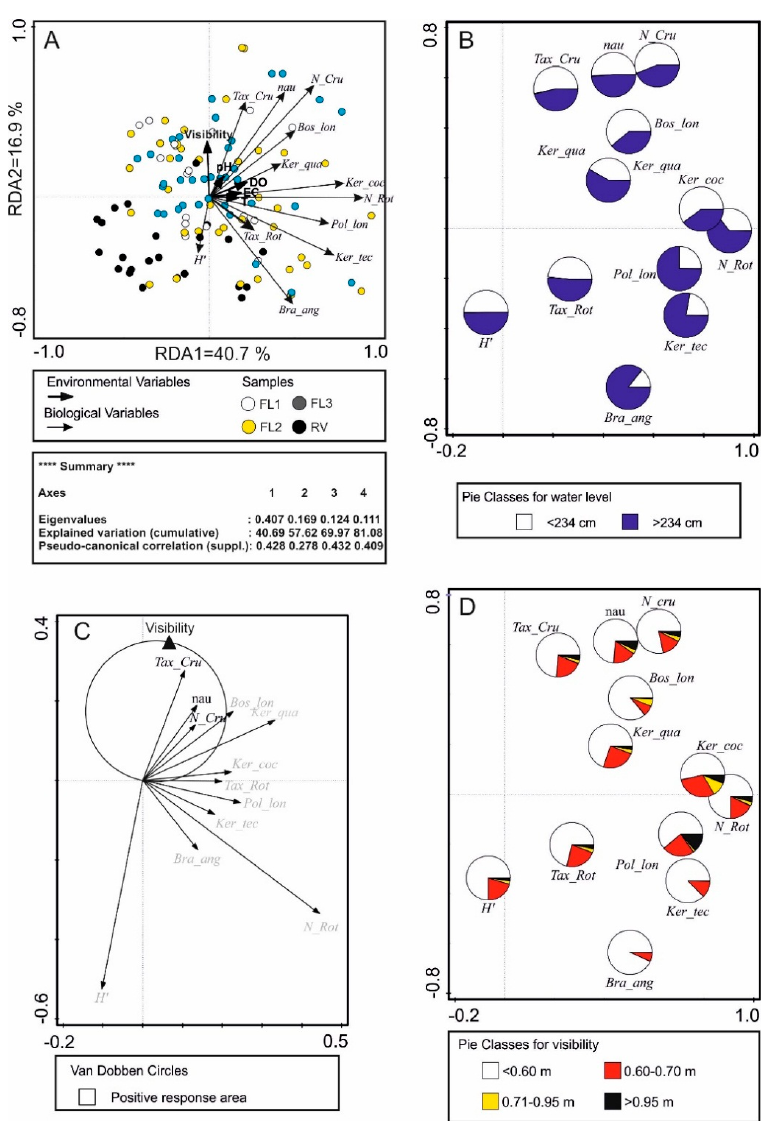
Figure 5. Results of redundancy analysis (RDA) performed on zooplankton and environmental data for the three types of floodplain lakes using forward selection of variables ( p < 0.05). ( A ) Triplot of significant environmental variabilities, zooplankton and samples; ( B ) relative values of zooplankton communities (pies charts) in relation to the water level in river channel and floodplain lakes (<234 cm—limnophase, >234 cm—potamophase); ( C ) Van Dobben circles analysis (visibility vs. zooplankton structure). A circle indicates positive responses; ( D ) relative values of zooplankton